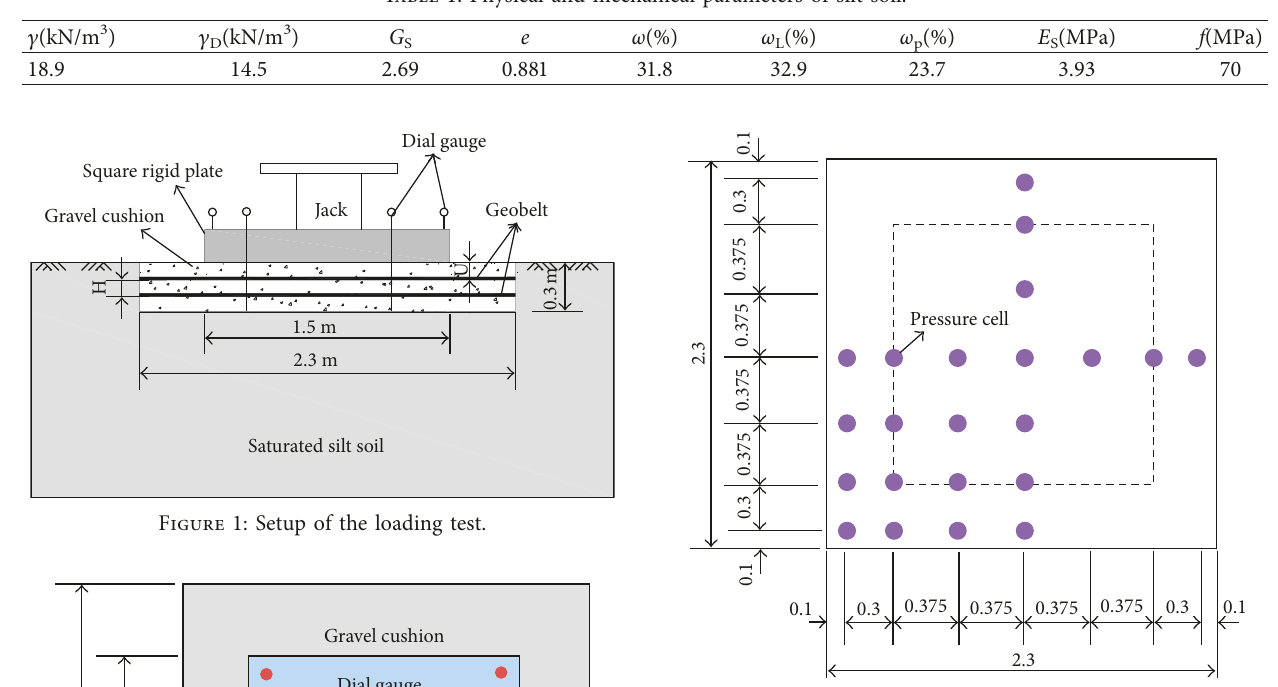
Figure 3: Distribution of pressure cells (unit: m). Table 2: Testing